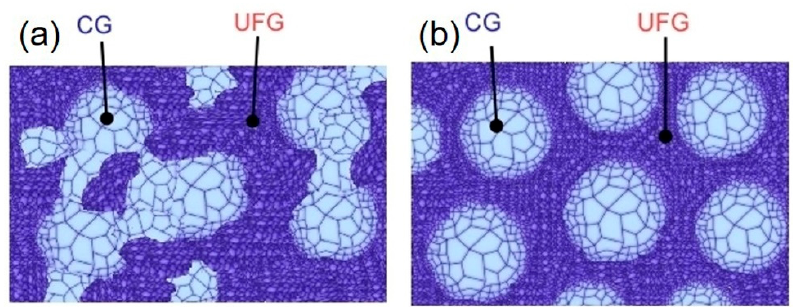
Figure 1. Schematic of ( a ) bimodal structure and ( b ) harmonic structure.